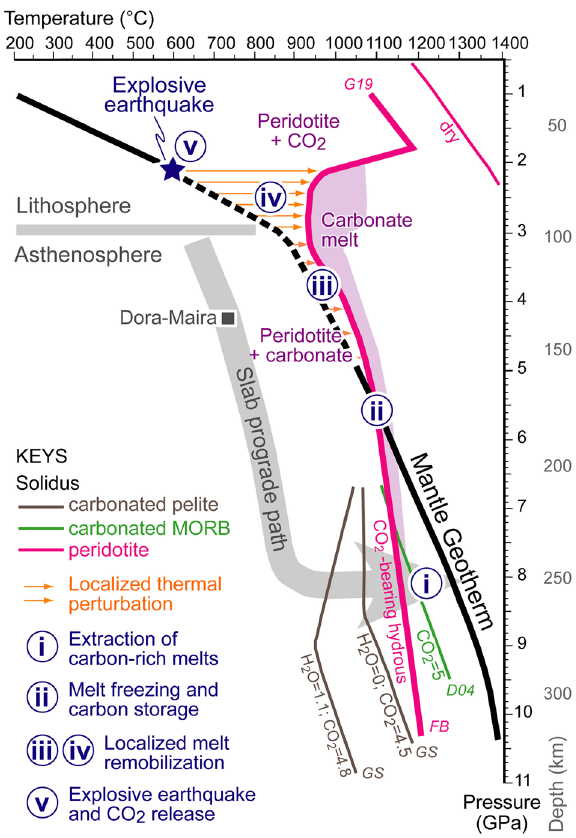
Fig. 3 Pressure – temperature path of ascending carbon-rich melts based on experimentally determined melting relations. The gray arrow indicates the European lithosphere cold subduction path to asthenospheric depths 3 . Progressive thermal re-equilibration of the slab (horizontal arrow segment) to mantle geotherm 49 (black line) induces partial melting of subducted carbonated hydrous metasediments (GS 9 ) and carbonated meta basics (D04 8 ). Generated carbon-rich hydrous melts determine supersolidus conditions (thick magenta line FB 10,11 ) in the mantle-wedge peridotite. The temperature difference between the CO 2 -bearing hydrous peridotite solidus and the mantle geotherm decreases with decreasing pressures and the two curves intersect at ~180 km. At shallower depths, carbon-rich melts are frozen on reaction with peridotites 3 . In the uppermost asthenospheric mantle, the CO 2 -bearing hydrous peridotite solidus segment (G19 13 ) runs near-parallel to the mantle geotherm, and minor thermal perturbations may induce partial melting generating carbon-rich melts (magenta fi eld) 50 . Additional heating would be required for melting at the base of the lithosphere, where the CO 2 -bearing hydrous peridotite solidus diverges sharply from the mantle geotherm. The CO 2 -bearing hydrous peridotite solidus loop at ~2 GPa, in the depth range of the explosive earthquake recorded beneath Milan, re fl ects carbonate destabilization with the consequent shift of the solidus towards higher temperatures. In the diagram, the uppermost part of the mantle geotherm is constrained by earthquake depth; the dotted part is inferred. Roman numbers i – v indicate steps described in Fig. 4. Image generated using Inkscape 1.0 (https:// is in fact necessarily transmitted to the underlying asthenosphere because the Adriatic plate has a reverted-U shape due to the presence of two opposite-dipping slabs attached to its north- eastern and southwestern edges 14,34 . Deformation of the astheno- spheric mantle produces lattice-preferred-orientation of olivine crystals, which is revealed by the birefringence of core-refracted shear waves (SKS phase) and associated transverse anisotropy of